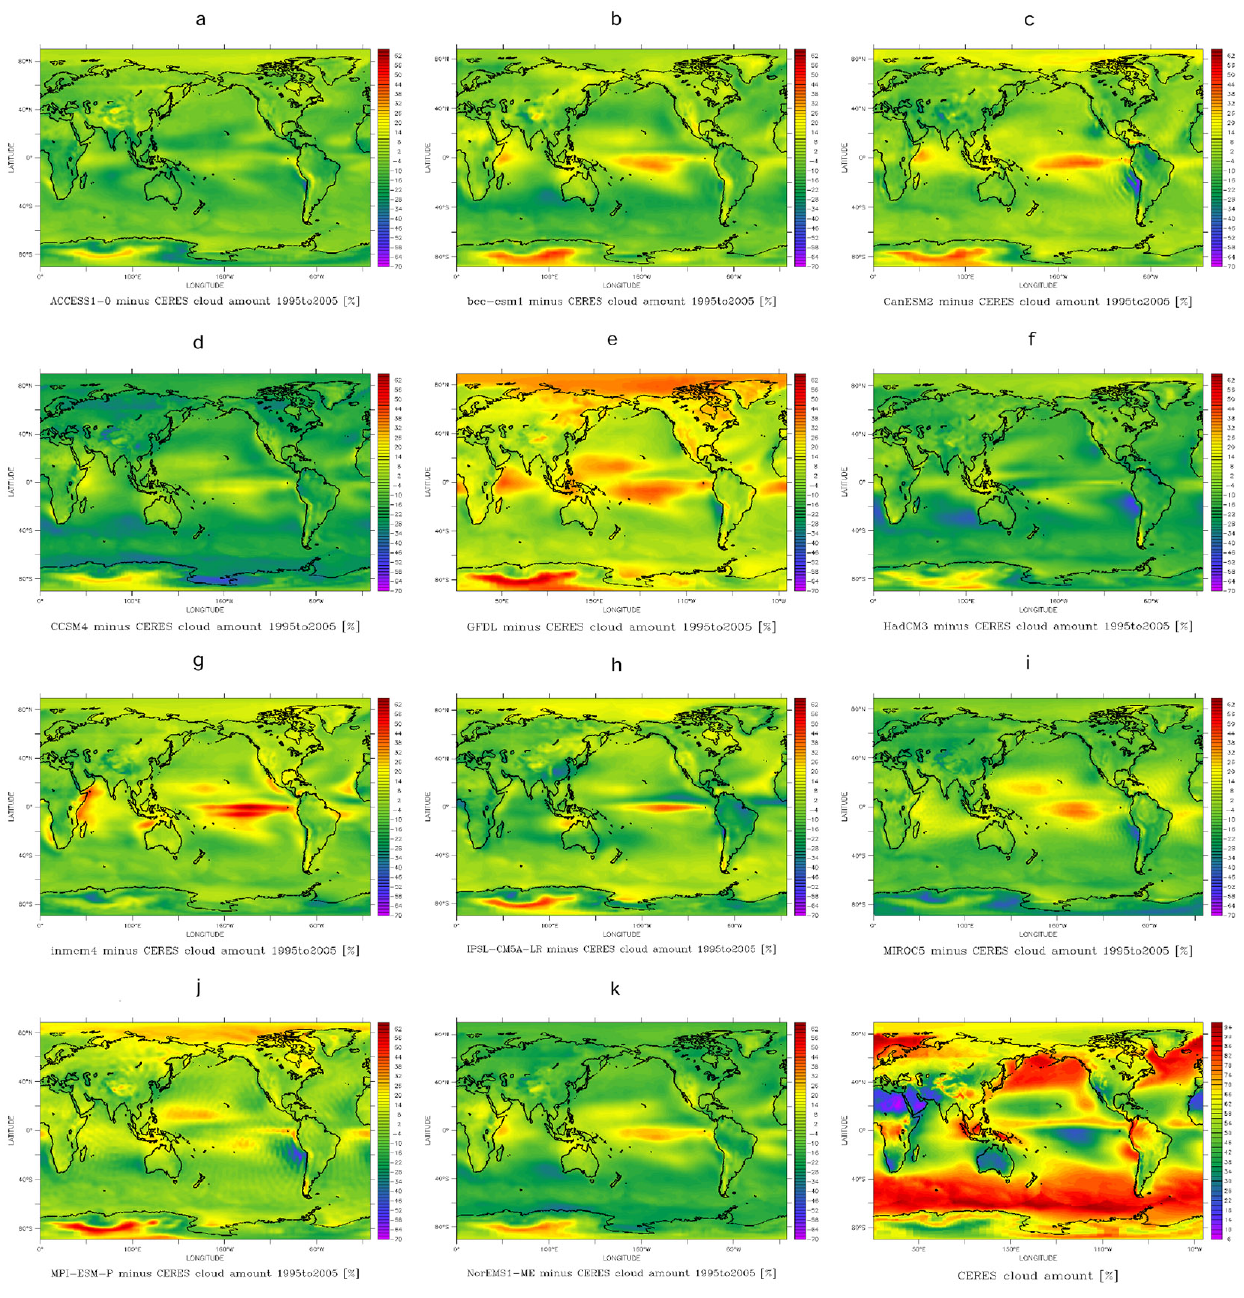
Figure 4. Total cloud amount (CLT) for CERES and several CMIP5 models. Panels (a) to (k) show a map plot for the specific CMIP5 model minus CERES data. In the lowermost right corner is the CERES CLT plot. All plots are given in percent representing a 10-year mean. The color bar for the CERES CLT plots: 4 up to 100% and for the difference plots: − 70 up to